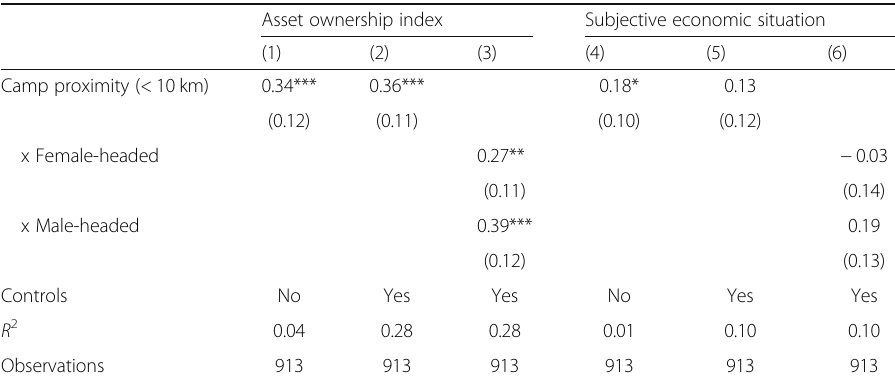
Table 8 Economic